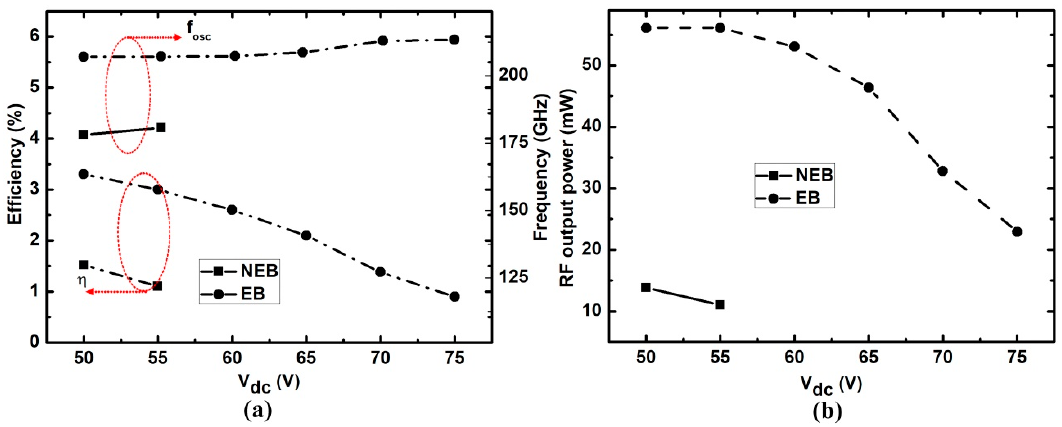
Figure 3. ( a ) Simulation results of the oscillation frequency f osc and dc-to-ac conversion efficiency η versus the anode voltage V dc and ( b ) RF output power P RF versus V dc under EB and NEB models.